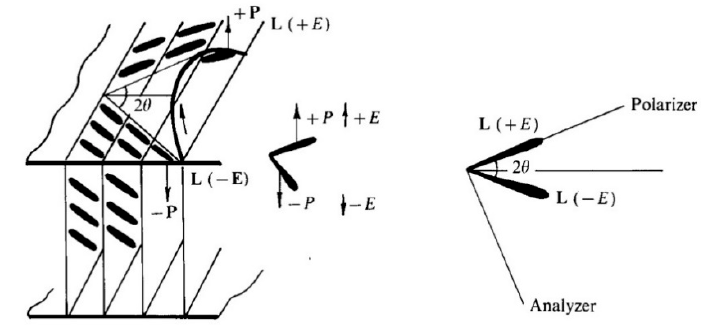
Figure 1. Geometry of surface stabilized ferroelectric liquid crystals (FLC) cell.